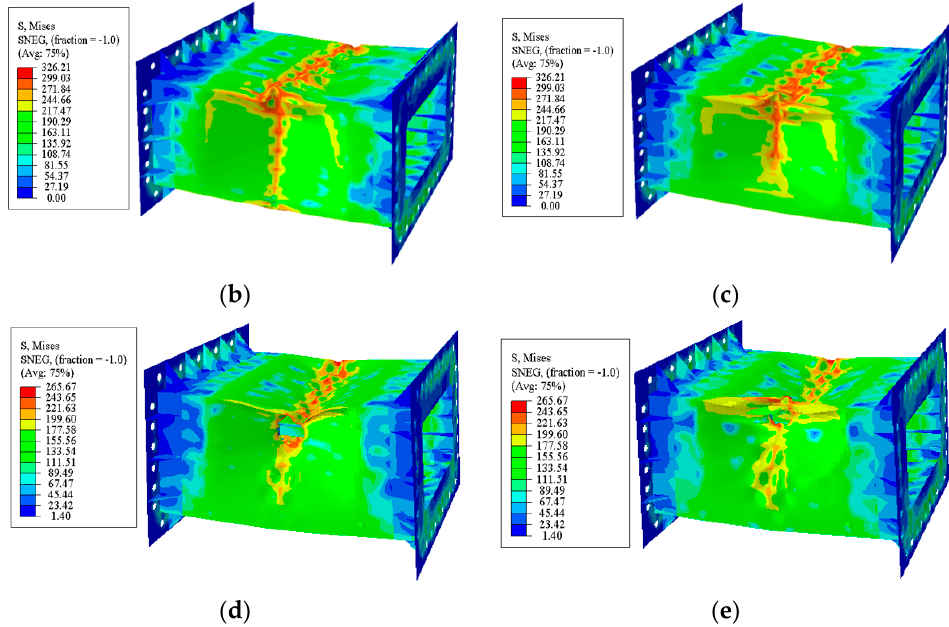
Figure 25. Collapsed shapes of the box girder models: ( a ) IB-1; ( b ) DB-2; ( c ) DB-4; ( d ) DB-5; ( e ) DB-